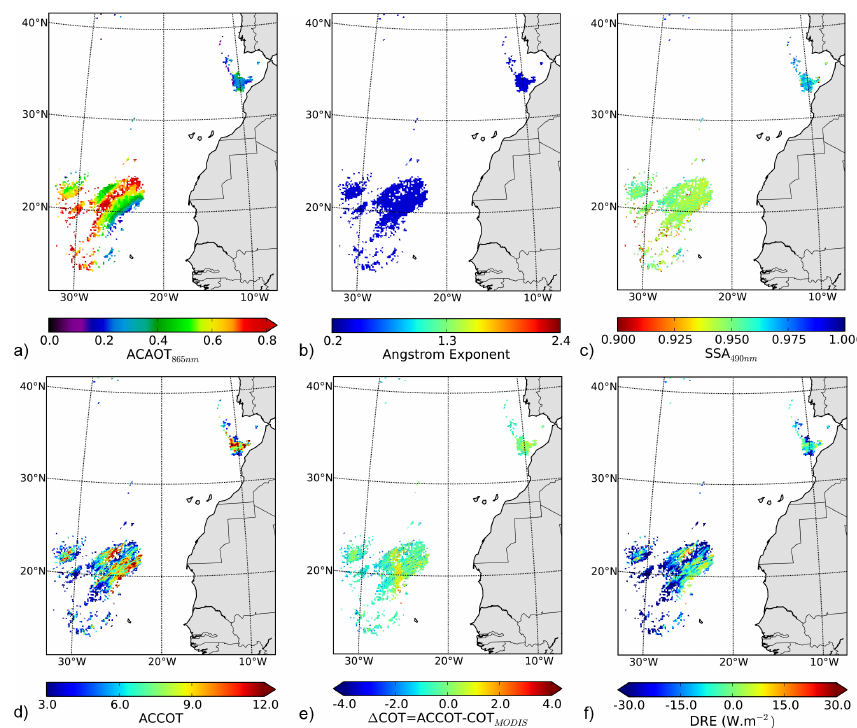
Figure 9. Same as Fig. 7 for Saharan dust above clouds on 4 August 2008, except Fig. 9c that displays the aerosol SSA at